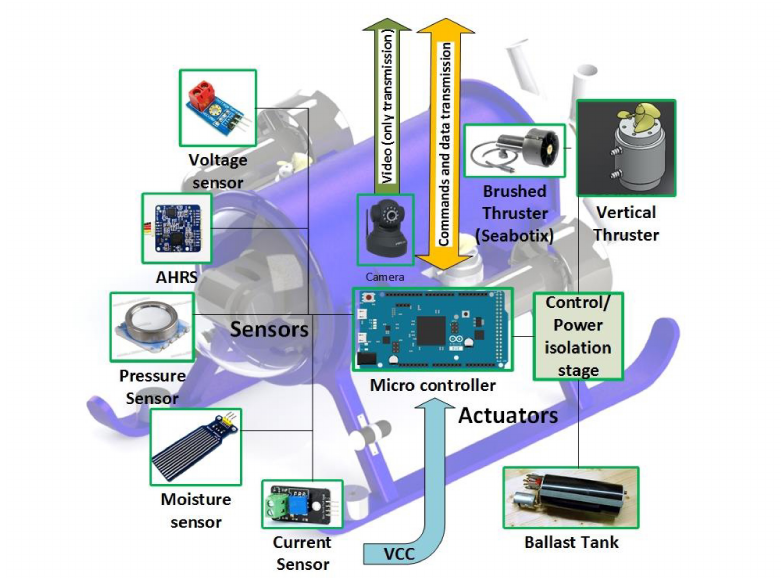
Figure 16. Electronic Architecture of the mini-ROV.